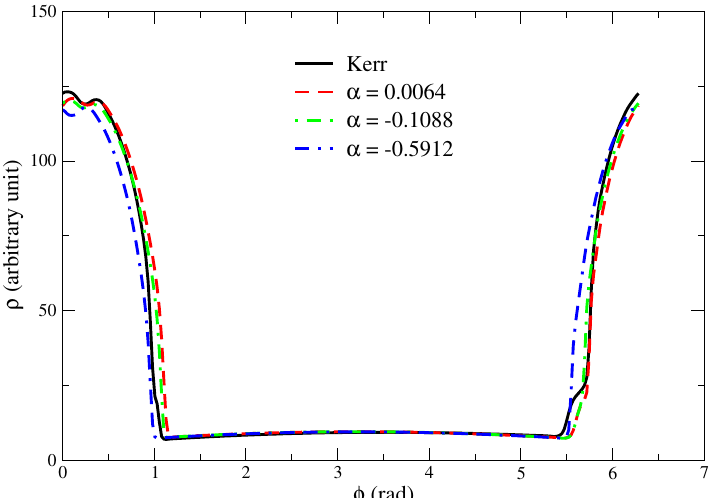
Figure 3. The densities of shock cones showing the locations of discontinuities plotted as a function of angular distance at fixed r = 4.78 M for asymptotic velocity V ∞ = 0.1.